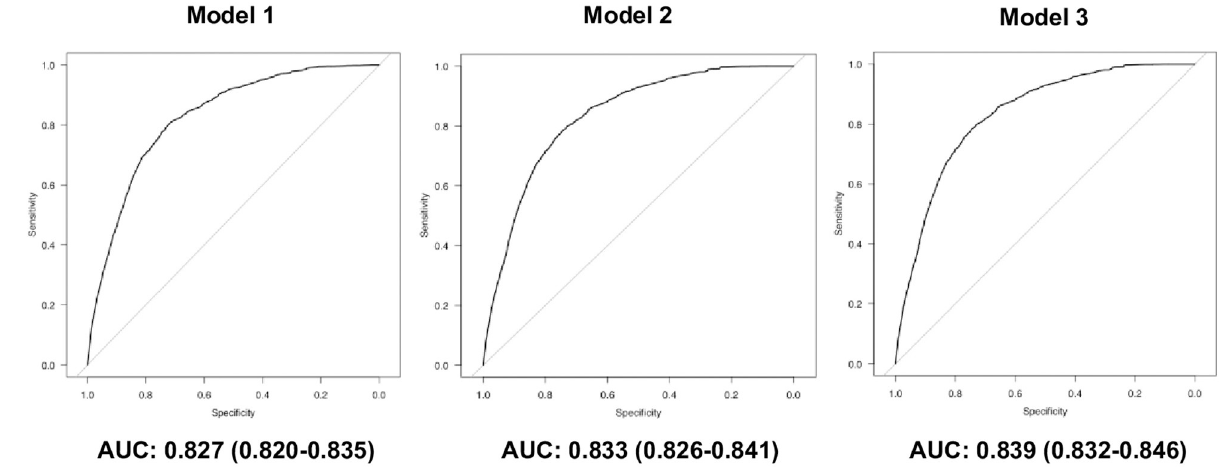
Fig 3. ROC curves for each model to predict prolonged ICU